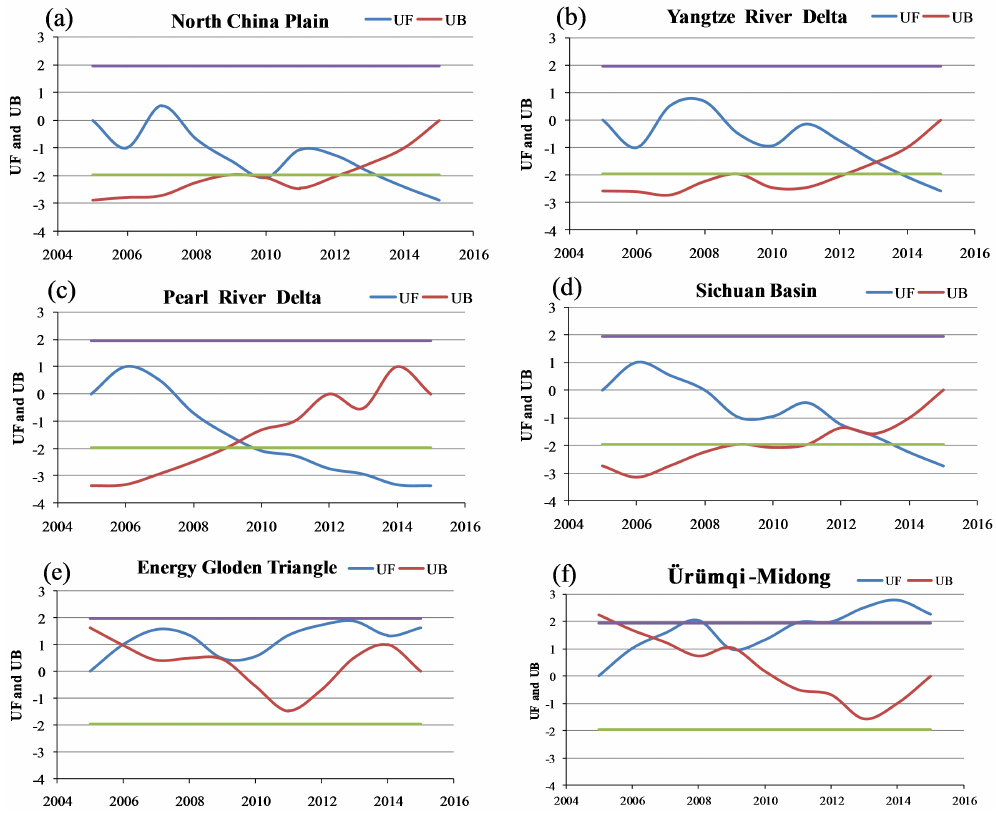
Figure 6. Mann–Kendall (MK) test statistics for annual SO 2 VCD in those highlighted regions (Figs. 1 and 4b) from 2005 to 2015. The blue solid line is the forward sequence UF k and the red solid line is the backward sequence UB k defined by Eq. (5). The positive values for UF k indicate an increasing trend of SO 2 VCD, and vice versa. Two straight solid lines stand for confidence interval between − 1.96 (straight green line) and 1.96 (straight purple line) in the MK test. The intersection of UF k and UB k sequences within the intervals between two confidence levels indicates a step change point.